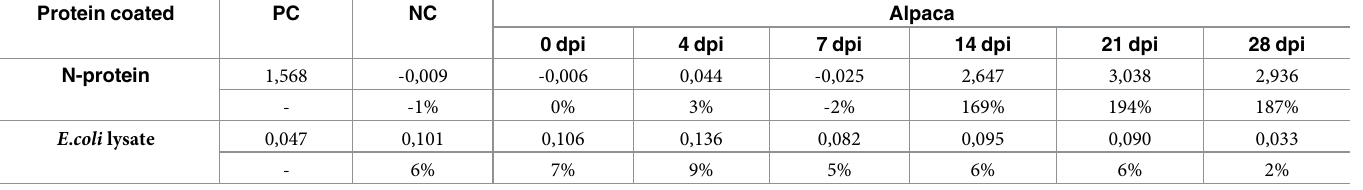
Table 2. Immunization results (OD value and final result in % (fR = [R-sample/R-positive] � 100)) of the alpaca in the novel camel-specific IgG ELISA using two dif- ferent coating proteins (N-Protein of Kosovi-Hoti and E . coli lysate). Protein coated N-protein E . coli